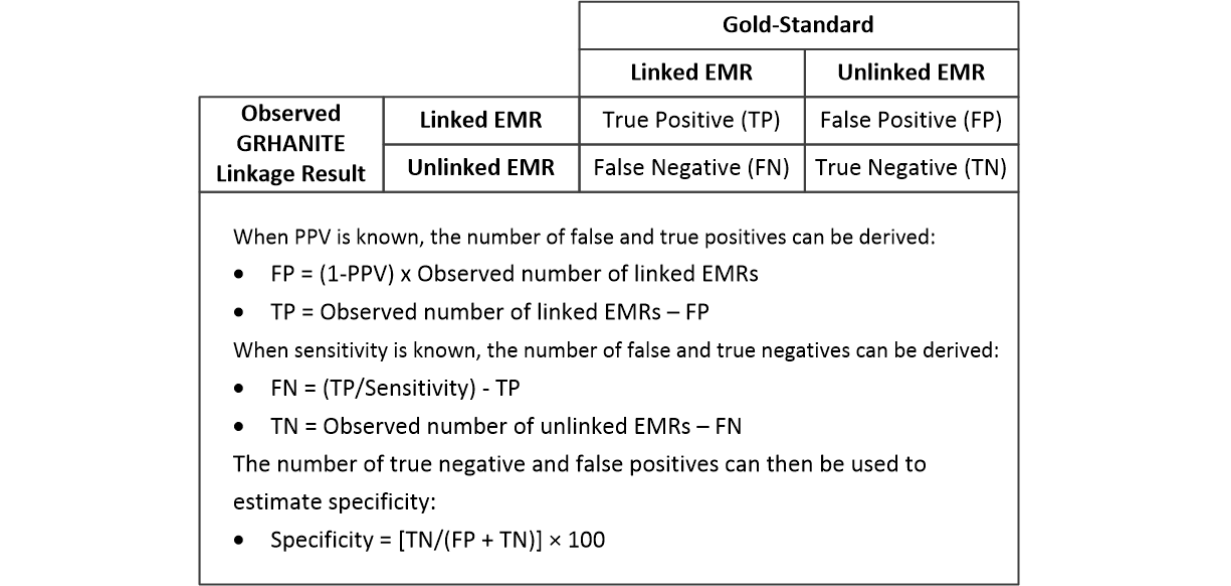
Figure 5. Estimating specificity when positive predictive value and sensitivity are